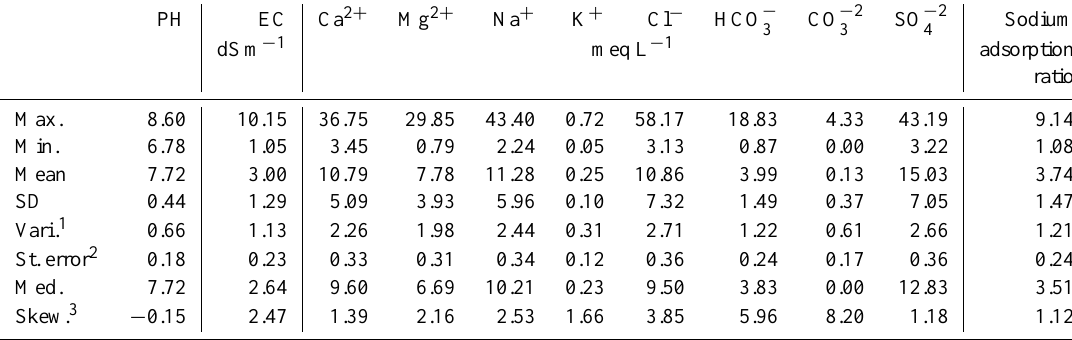
Table 4. Statistical analysis of groundwater chemical composition of Al-Kharj ( n = 180).